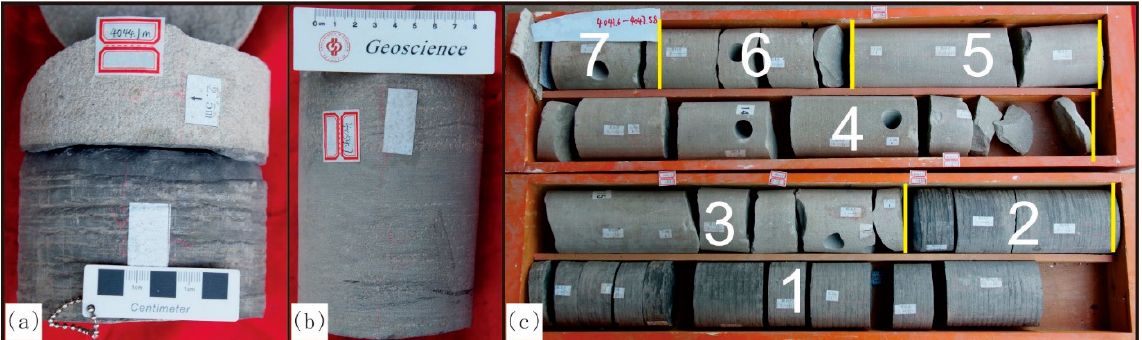
Figure 6. Typical sedimentary structure of subaqueous distributary channel microfacies in shal ‐ low ‐ water delta inner front. ( a ) Well M16, 4044.10 m, scour surface structure; ( b ) Well M16, 4054.70 m, scour surface structure; ( c ) Well M16, 4041.60~4045.45 m, Multiphase river superposi ‐ tion.